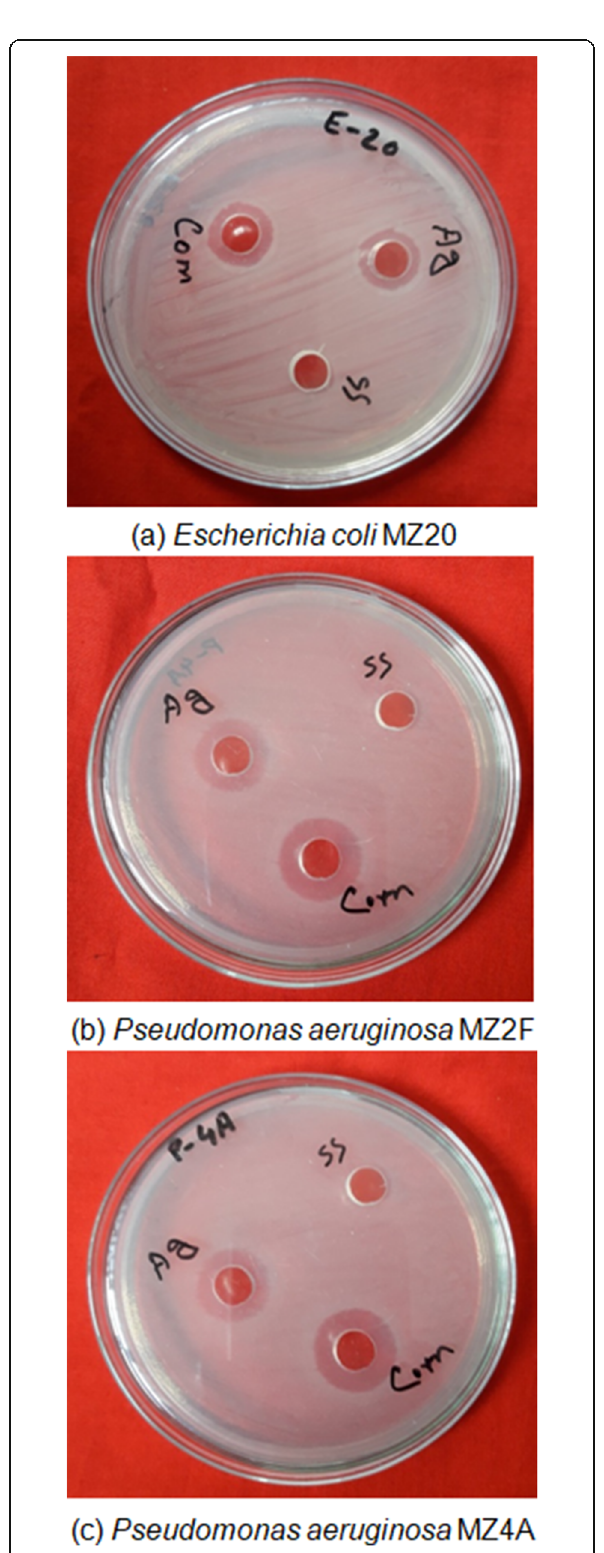
Fig. 6 Antibacterial activities of silk sericin (SS), 3 mM of silver nitrate (Ag), and SS-AgNPs (Com) on multidrug-resistant Escerichia coli and Pseudomonas aeruginosa